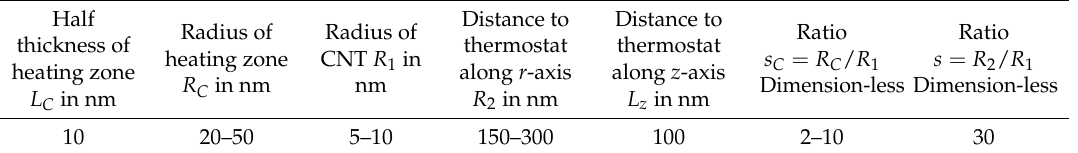
open symbols. Note that the temperature is counted from 𝑇 (cid:3047) . Table 2. Geometric parameters of the boundary value